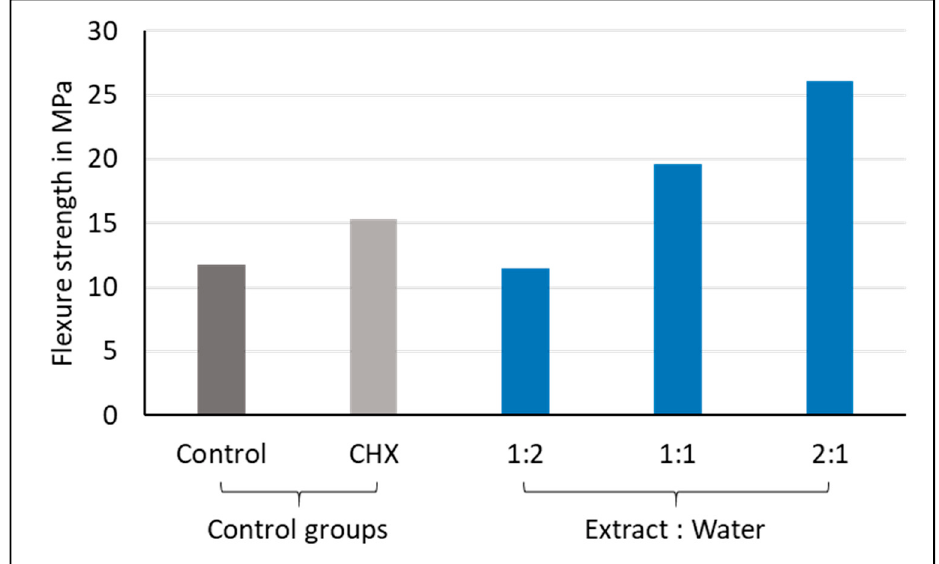
Figure 8. Median flexural strength values (MPa) showing intergroup comparisons of the control, CHX, and three plant-modified groups (1:2, 1:1, 2:1). and three plant-modified groups (1:2, 1:1, Table 3. Results of Kruskal–Wallis H test and pairwise comparison for the flexural strength values of the control, CHX, and three plant-modified groups (1:2, 1:1, 2:1).